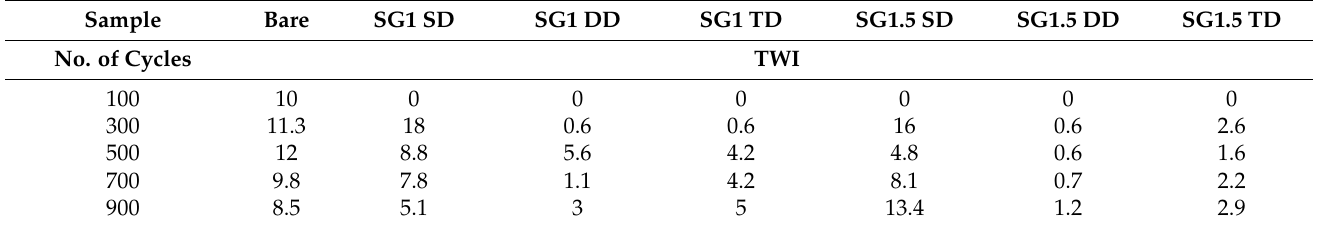
Table 3. Taber Wear Index (TWI) values for uncoated, single, double and triple coated samples.